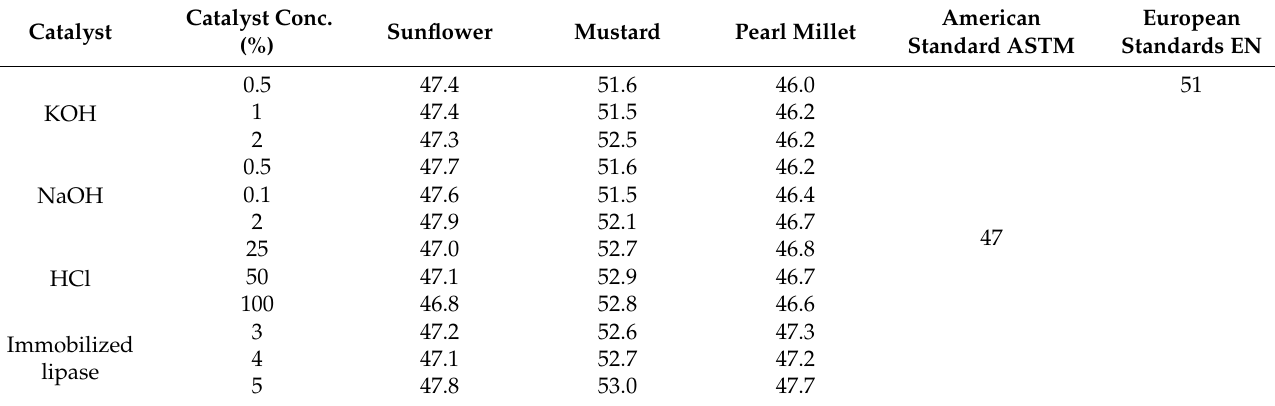
Table 5. Cetane number (CN) of biodiesel from sunflower, mustard, and pearl millet seed oils. Catalyst Catalyst